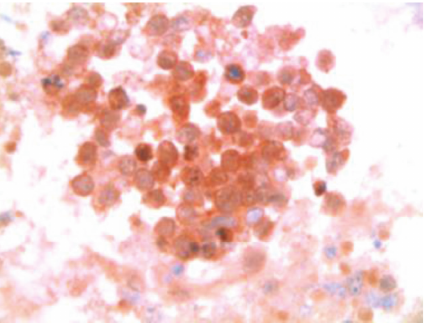
Figure7:Microscopicimageoflesionalcellsshowingbothcytoplas- mic and nuclear reactivity with p16, suggesting an HPV mediated disease process (p16 immunocytochemistry, Cell Block,